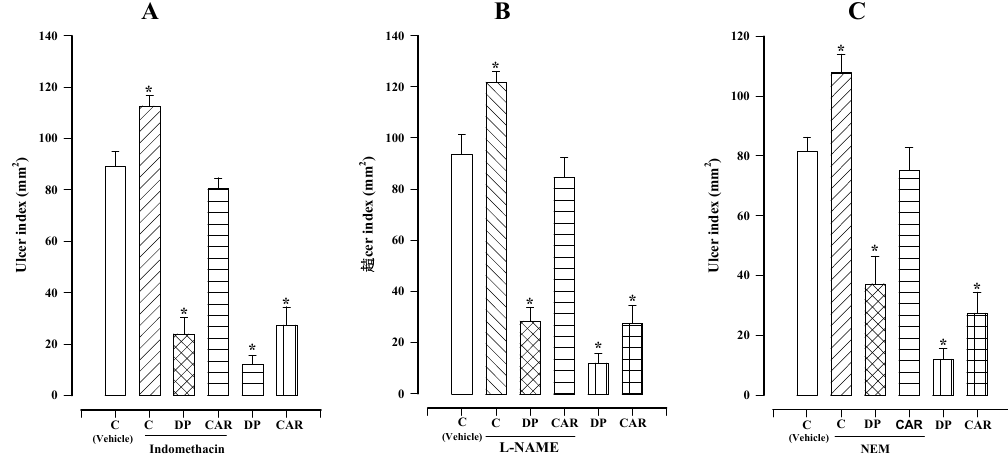
Figure 3. Effect of dillapiole (DP) and carbenoxolone (CAR) at 100 mg/kg on gastric lesions induced by ethanol in rats pretreated with ( A ) indomethacin (10 mg/kg), ( B ) L -NAME (70 mg/kg) or ( C ) NEM (10 mg/kg). Bars represent the mean ± SEM (n = 10). * p < 0.05 vs. the respective control; Dunn’s multiple comparison test after Kruskal-Wallis